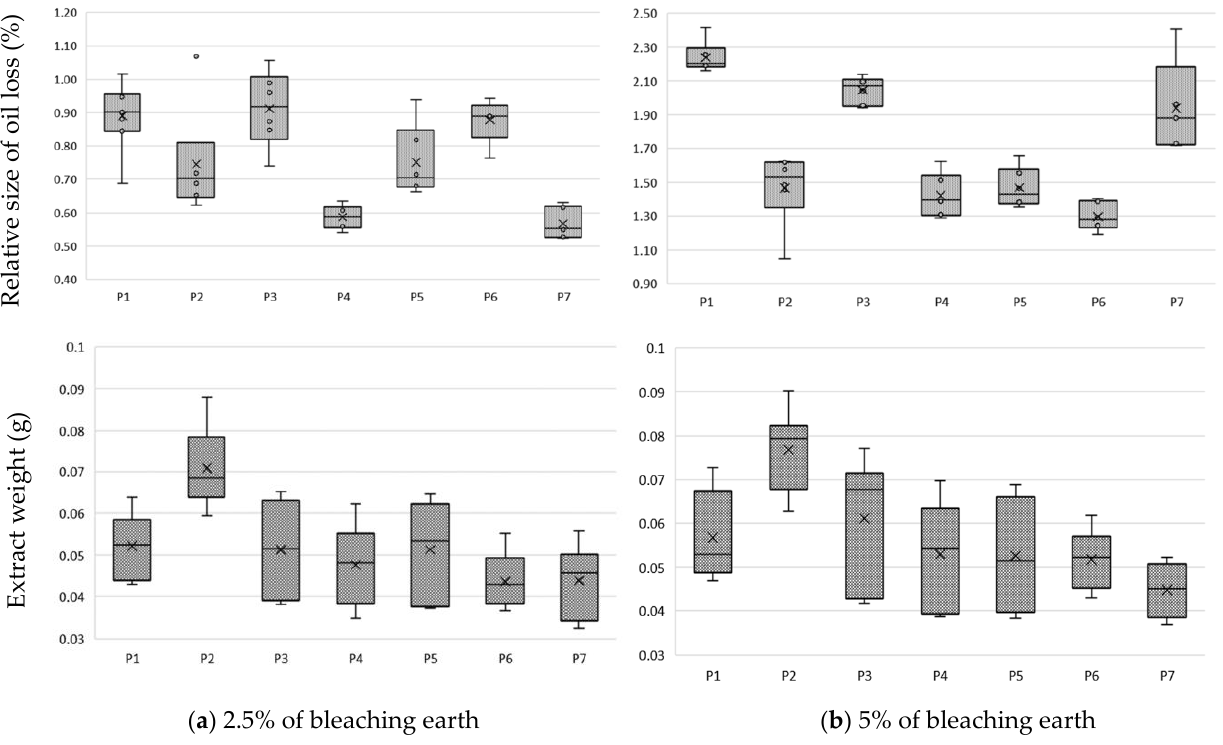
Figure 2. Loss of oil due to bleaching and the amount of extract extracted using earth at: ( a ) 2.5% m/m; ( b ) 5% m/m; mean and standard deviation of n = 6. Table 1. The results of the MANOVA multivariate analysis of variance test for phytosterols’ analysis (Wilks test; p <